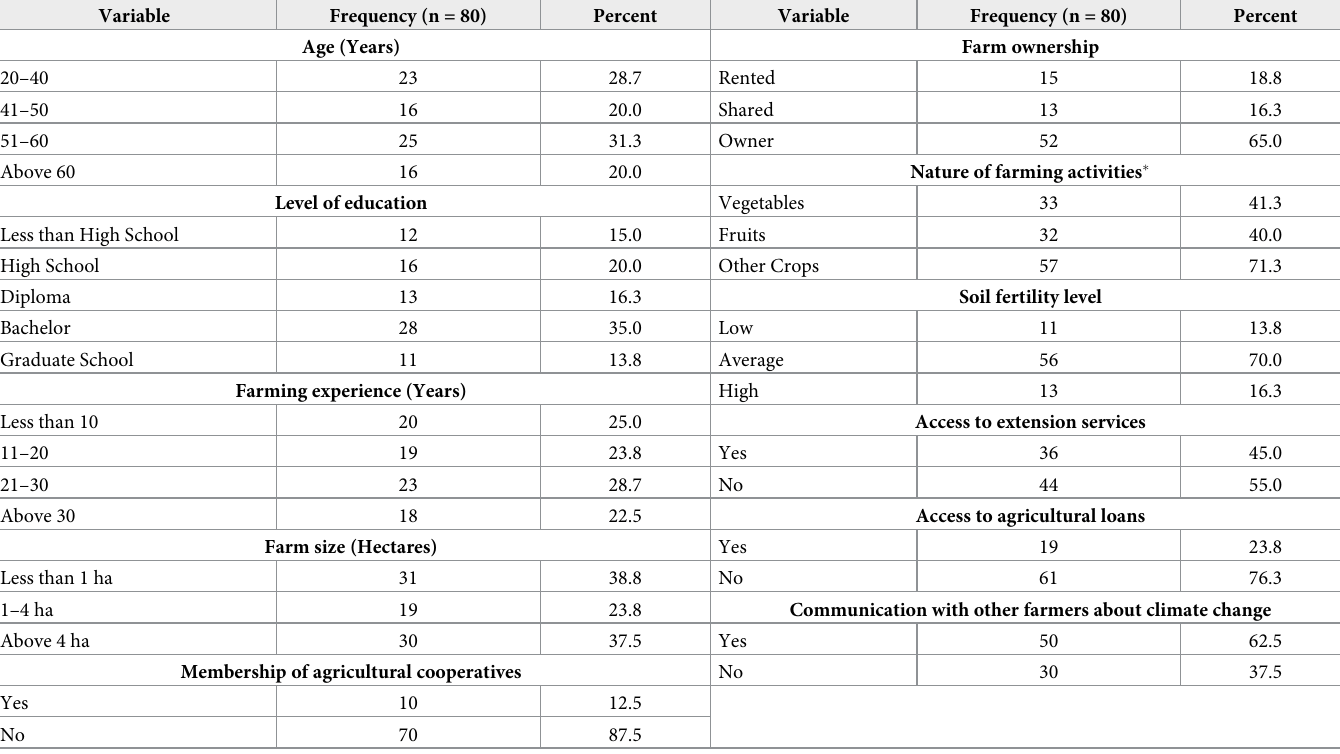
Table 1. Farmers’ demographic characteristics.